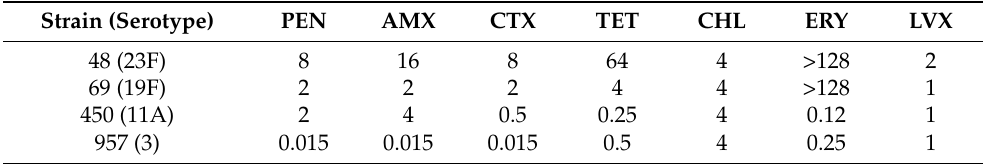
Table 1. Pneumococcal clinical isolates used in this study. Serotype is indicated as well as the minimum inhibitory concentration (MIC) ( µ g/mL) to different antibiotics 1